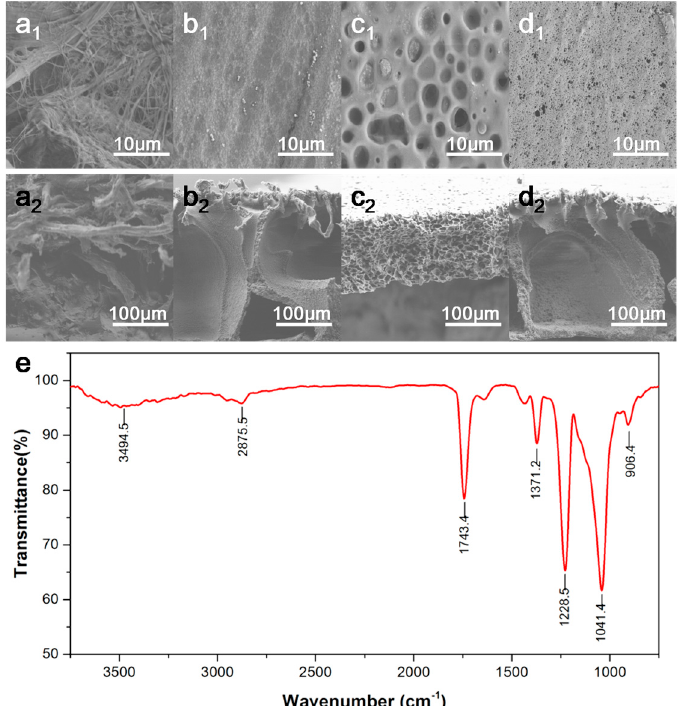
Figure 1. SEM images of the surface ( a 1 , b 1 , c 1 , d 1 ) and cross-section ( a 2 , b 2 , c 2 , d 2 ) of ( a ) a paper strip purchased from Whatman (England) with a bore diameter of 11 μ m, ( b ) CA membranes, ( c ) CA@LiCl membranes, and ( d ) CA@PEG-2000 membranes. ( e ) FTIR spectra of CA@PEG-2000 membranes. The FTIR spectra of CA@PEG-2000 membranes are shown in Figure 1e. The broad band around 3650-3450 cm − 1 represents the stretching of O − H, and the band due to C − H was located around 3000–2850 cm − 1 . The strong peak at 1743.4 cm − 1 in the FTIR spectrum could be attributed to the formation of new hydrogen bonds between the O − H groups of CA and the C=O bond of PEG-2000; the presence of these interactions implies excellent miscibility of CA and PEG-2000 in the blend membranes [24,25]. The presence of PEG-2000 in CA@PEG-2000 membranes resulted in bands at 1100 cm − 1 characteristic of PEG-2000 ether groups. The peak at 1371.2 cm − 1 indicates the bending of C − H, and 1228.5 cm − 1